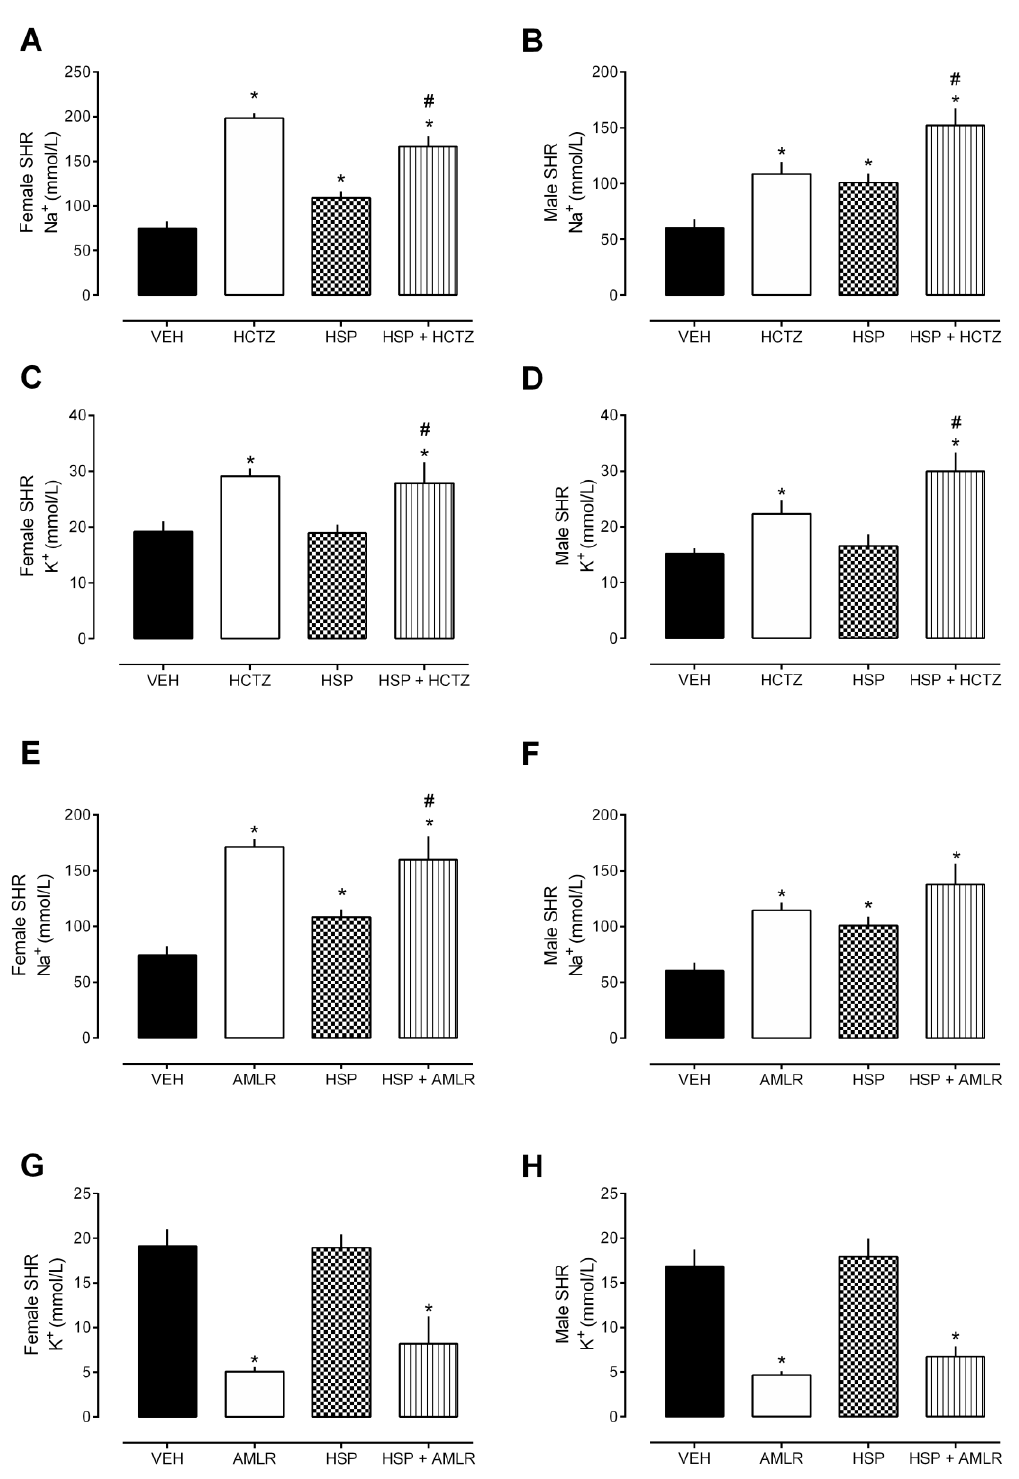
Figure 4. Urinary parameters (8 h) after oral treatment with hesperidin (HSP) in combination with hydrochlorothiazide (HCTZ) or amiloride (AMLR). ( A , B ) Urine Na + excretion after treatment with HSP plus HCTZ. ( C , D ) Urine K + excretion after treatment with HSP plus HCTZ. ( E , F ) Urine Na + excretion after treatment with HSP plus AMLR. ( G , H ) Urine K + excretion after treatment with HSP plus AMLR. The values show the mean ± SEM. Statistical analysis was performed by means of one-way ANOVA followed by Dunnett’s multiple comparisons test. * p < 0.05 when compared with the VEH (vehicle; saline 10 mL/kg); # p < 0.05 when compared with the HSP-only group.